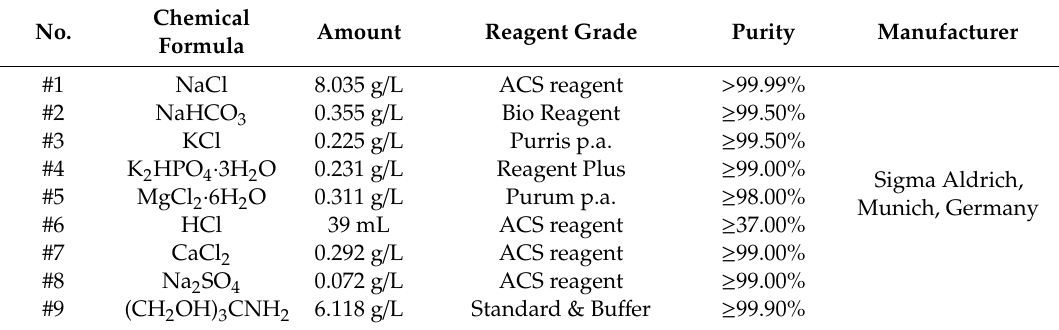
Table 3. Chemical composition and reagents grade and purity used for preparation of synthetic body fluid (SBF) media (1000 mL, pH = 7.4).